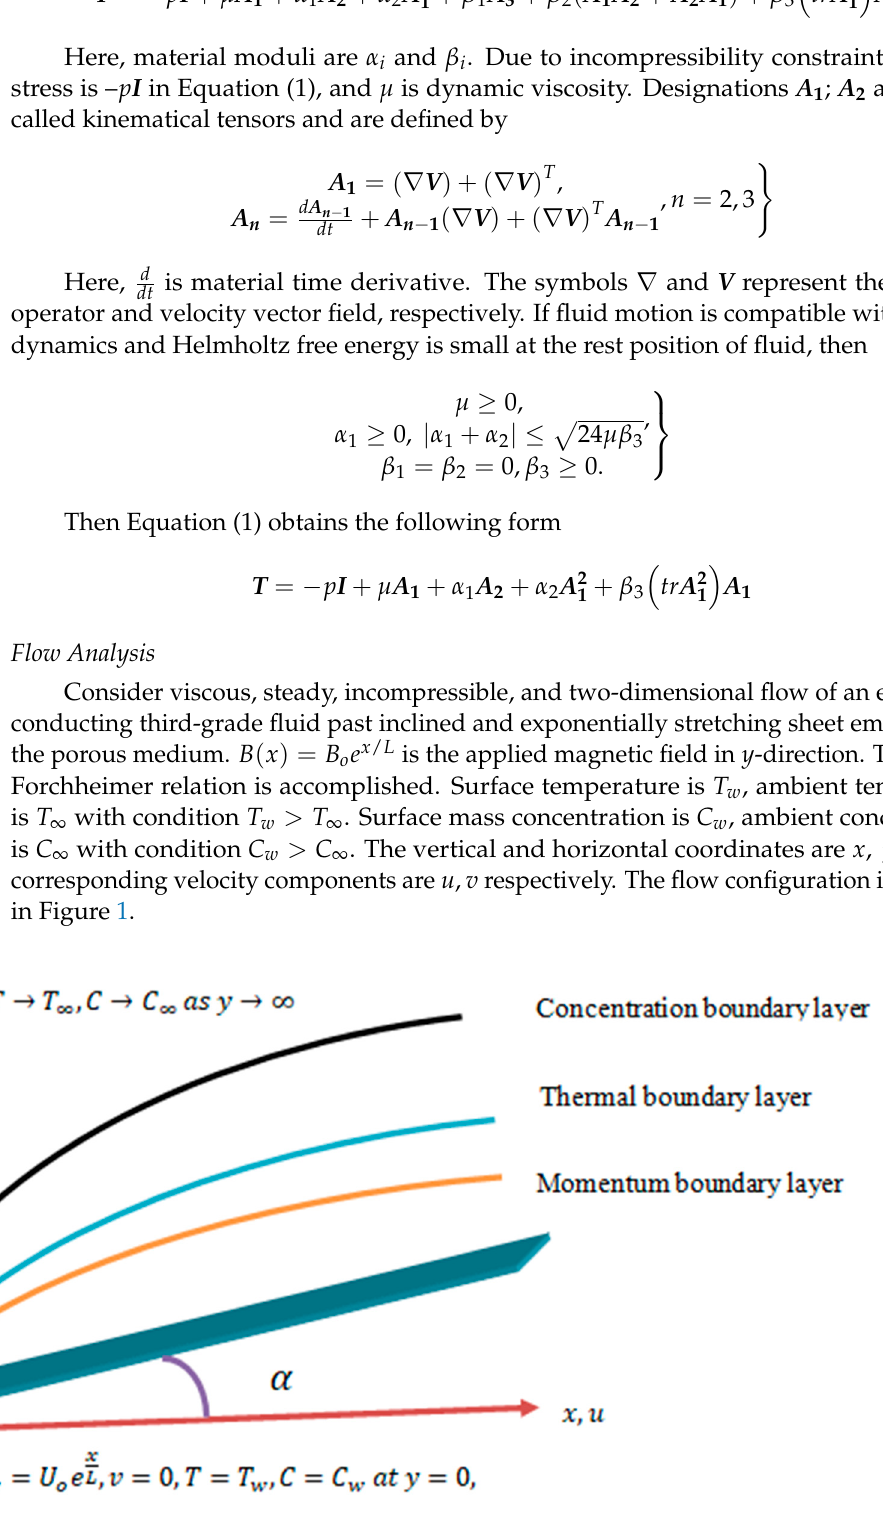
Figure 1. Flow configuration and coordinate system.